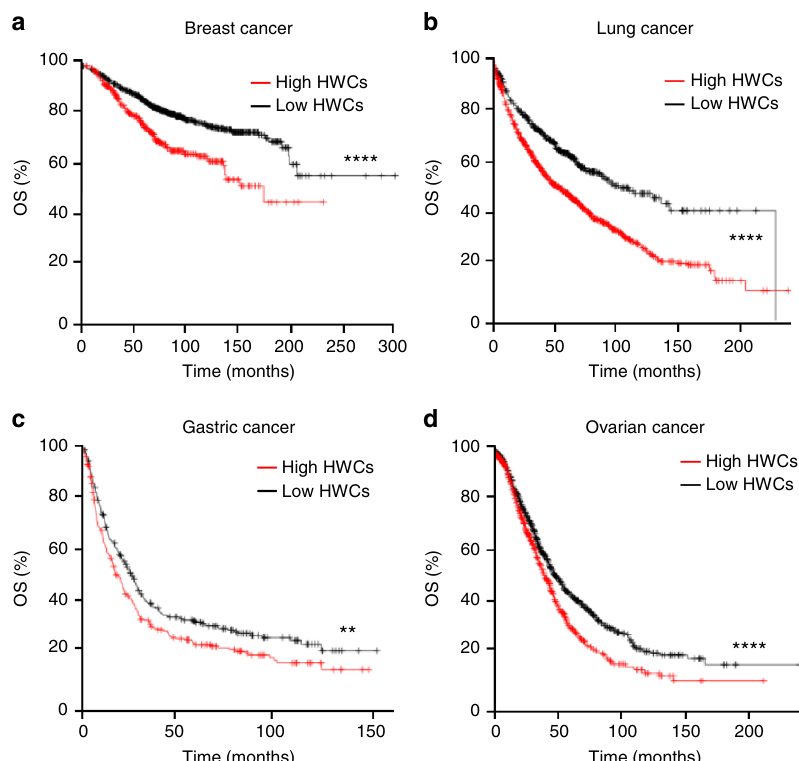
Fig. 3 The presence of a healing wound-like cytokine response is associated with poor prognosis in human cancers. Kaplan – Meier survival curves showing overall survival (OS) with high (red) and low (black) tumour expression of HWCs ( SPP1 , IL1B and IL6 ) for patients with a breast cancer ( n = 996 in HWCs lo group and 406 in HWCs hi group), b lung cancer ( n = 622 in HWCs lo group and 1304 in HWCs hi group), c gastric cancer ( n = 313 in HWCs lo group and 280 in HWCs hi group) and d ovarian cancer ( n = 843 in HWCs lo group and 813 in HWCs hi group). ** P ≤ 0.01, **** P ≤